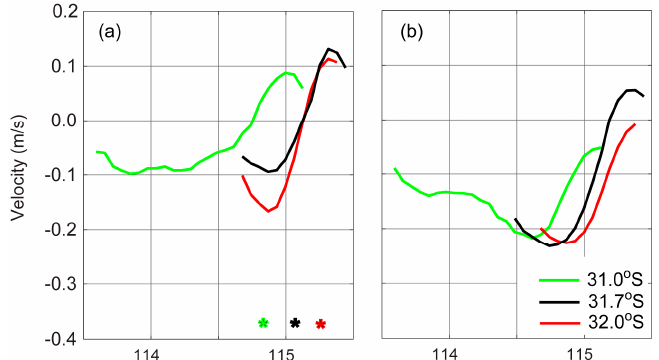
Figure 7. Mean cross-shelf profiles of HFR velocity at three different latitudes: at 31° S (green); 31.7° S (black); and, 32° S (red). Panel ( a ) refers to summer. Panel ( b ) refers to winter. The asterisks denote the locations of the 200 m depth contour. Units for the x -axis are °E.